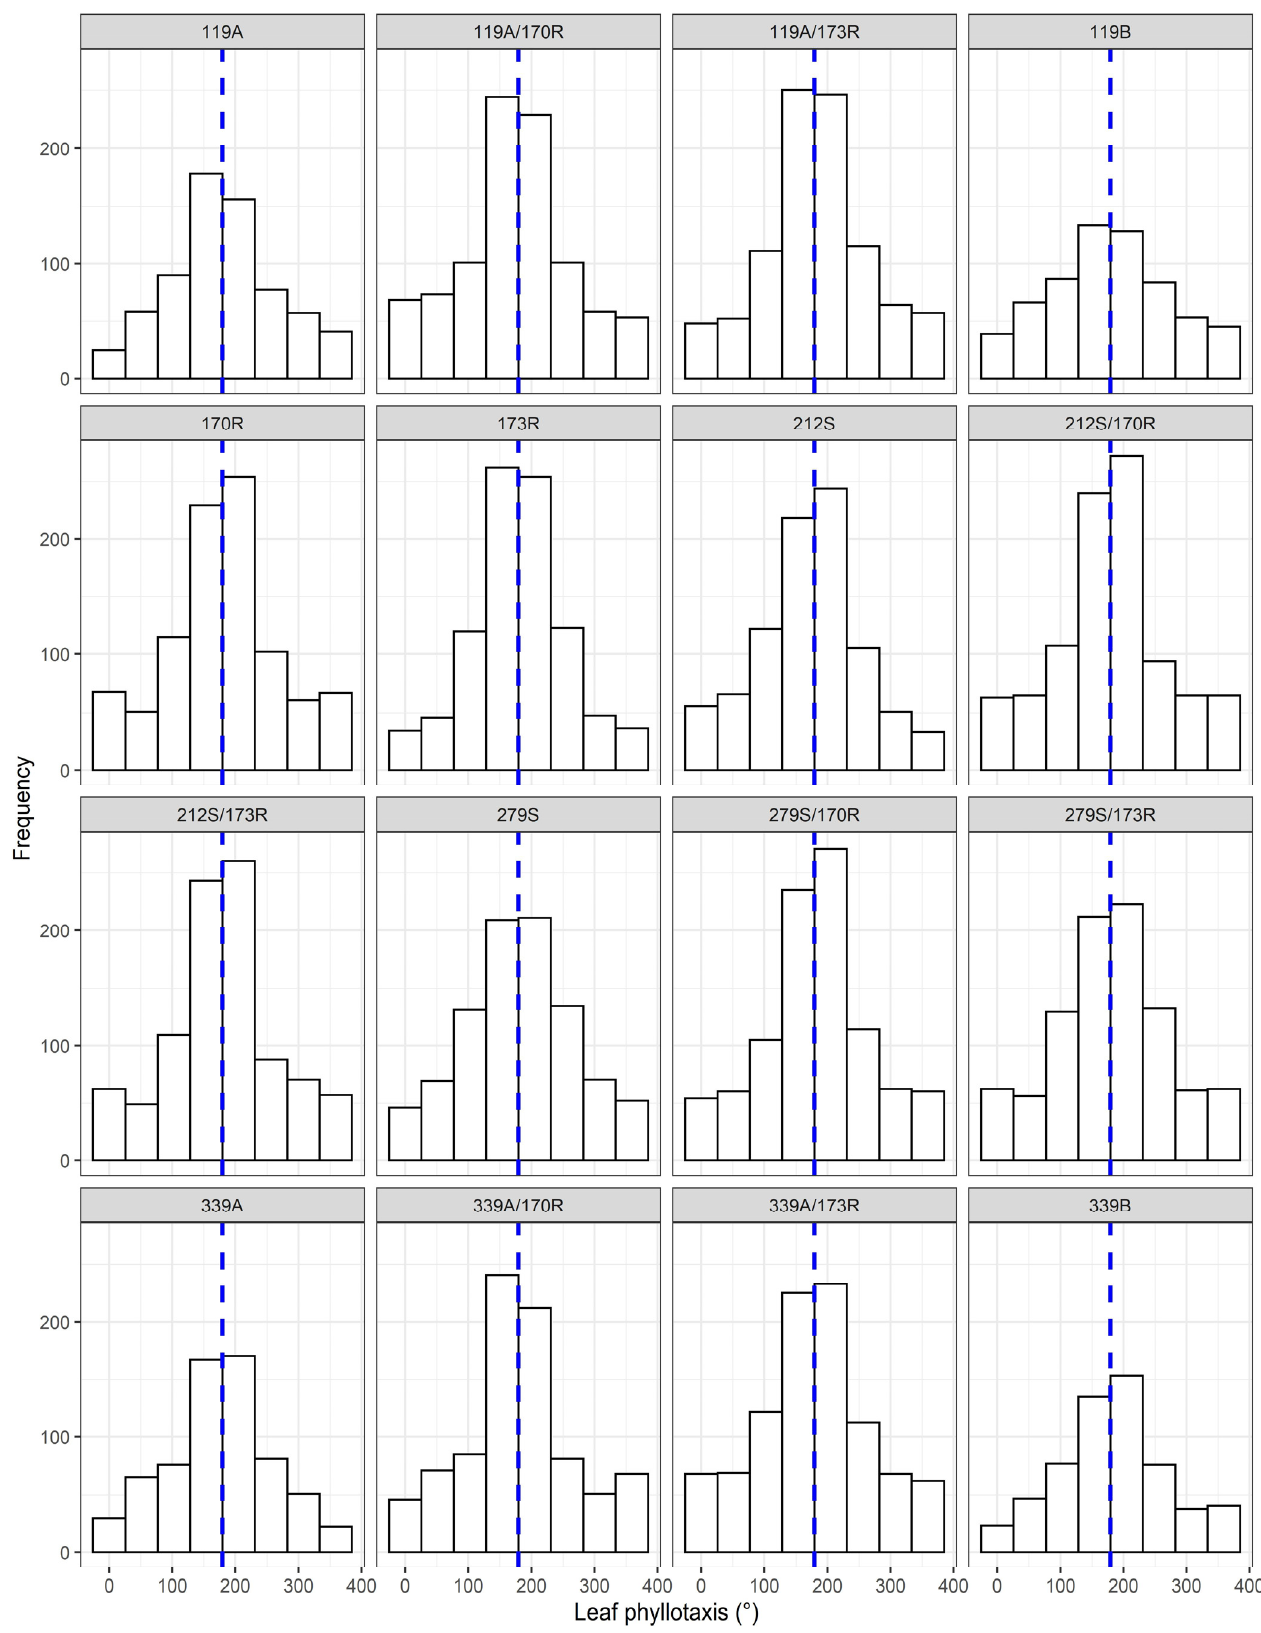
Figure 8. Frequency distribution of leaf phyllotaxis for different rice genotypes (the dashed vertical blue line represents the mean).